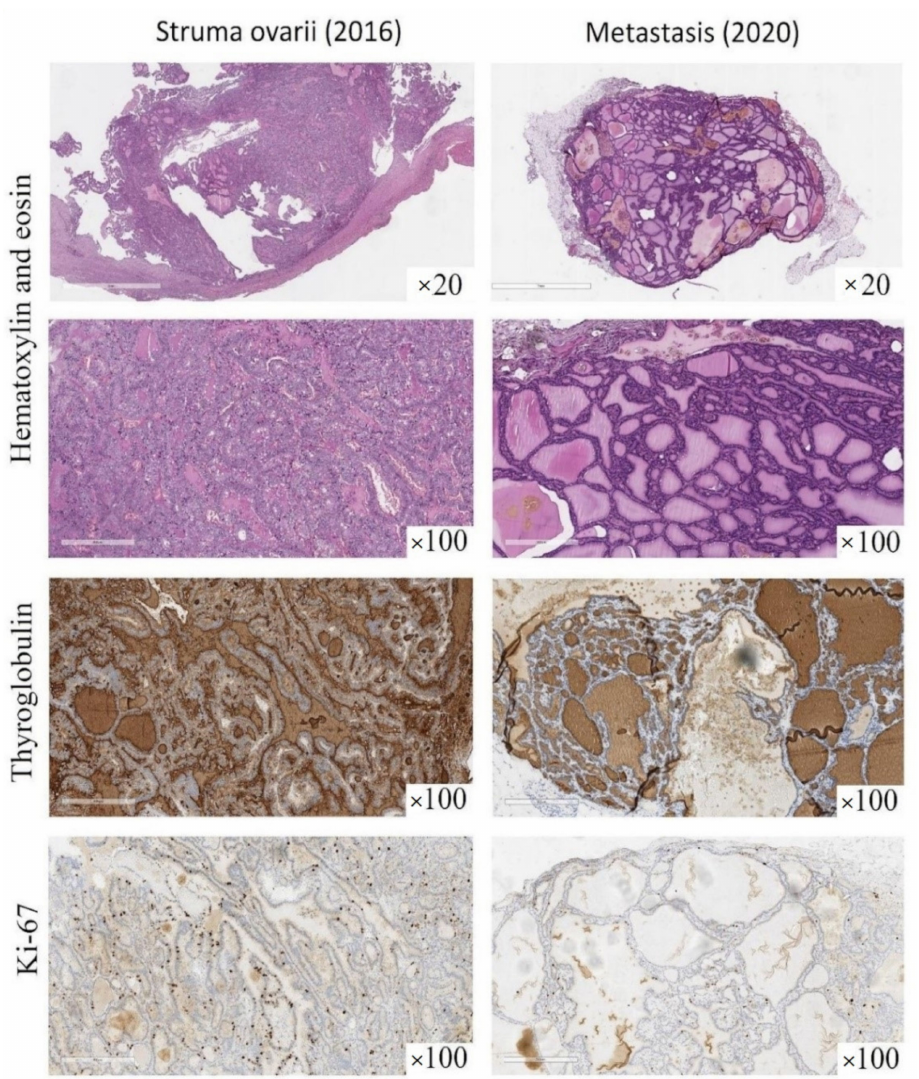
Figure 6. Morphology and immunohistochemical profile of ovarian struma and peritoneal deposits (previously unpublished, original photos). The primary ovarian neoplasm ( left column ) as well as the subsequent metastasis ( right column ) demonstrated macro- and micro-follicles containing colloid. The follicles were more densely packed in the primary ovarian neoplasm (“proliferative” struma), lacking the typical features of papillary or follicular carcinoma. In both specimens, tumor cells were diffusely positive for thyroglobulin immunostain (clone EPR 9730, rabbit monoclonal, dilution 1:500, Abcam, Cambridge, UK), while the Ki-67 labeling index was below 5% (clone 30-9, rabbit monoclonal, RTU; Ventana Medical Systems, Oro Valley, AZ,